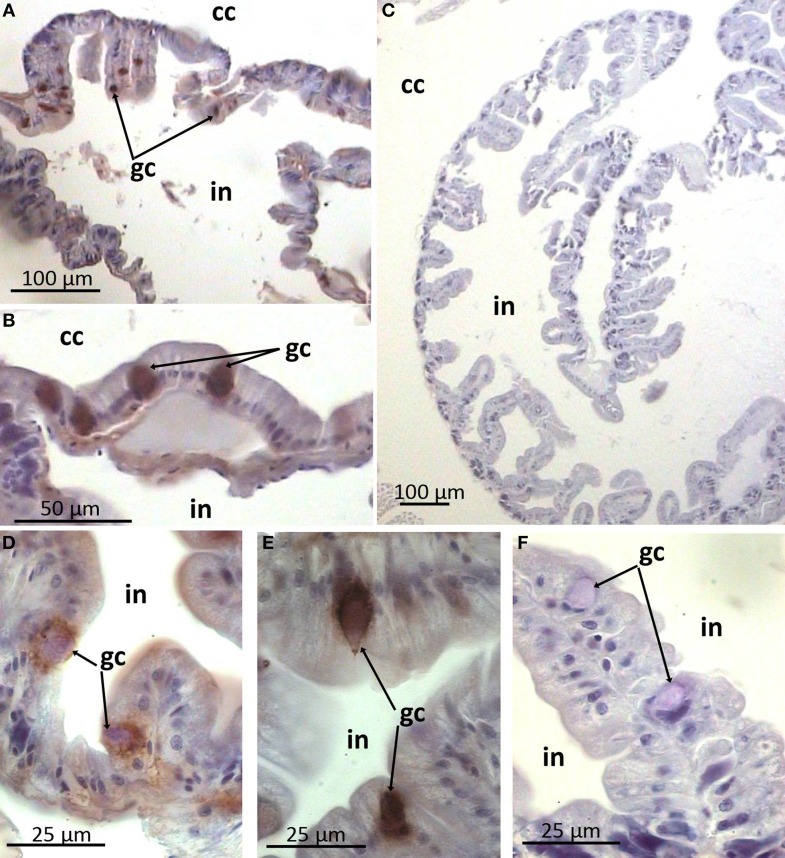
Arenicin-positive immunoreactivity of lugworm intestine. A,C, general view of intestine; B,D–F: sparse immunopositive cells; C,F, negative controls; cc, coelomic cavity; gc, presumable gland cells; in, intestine.